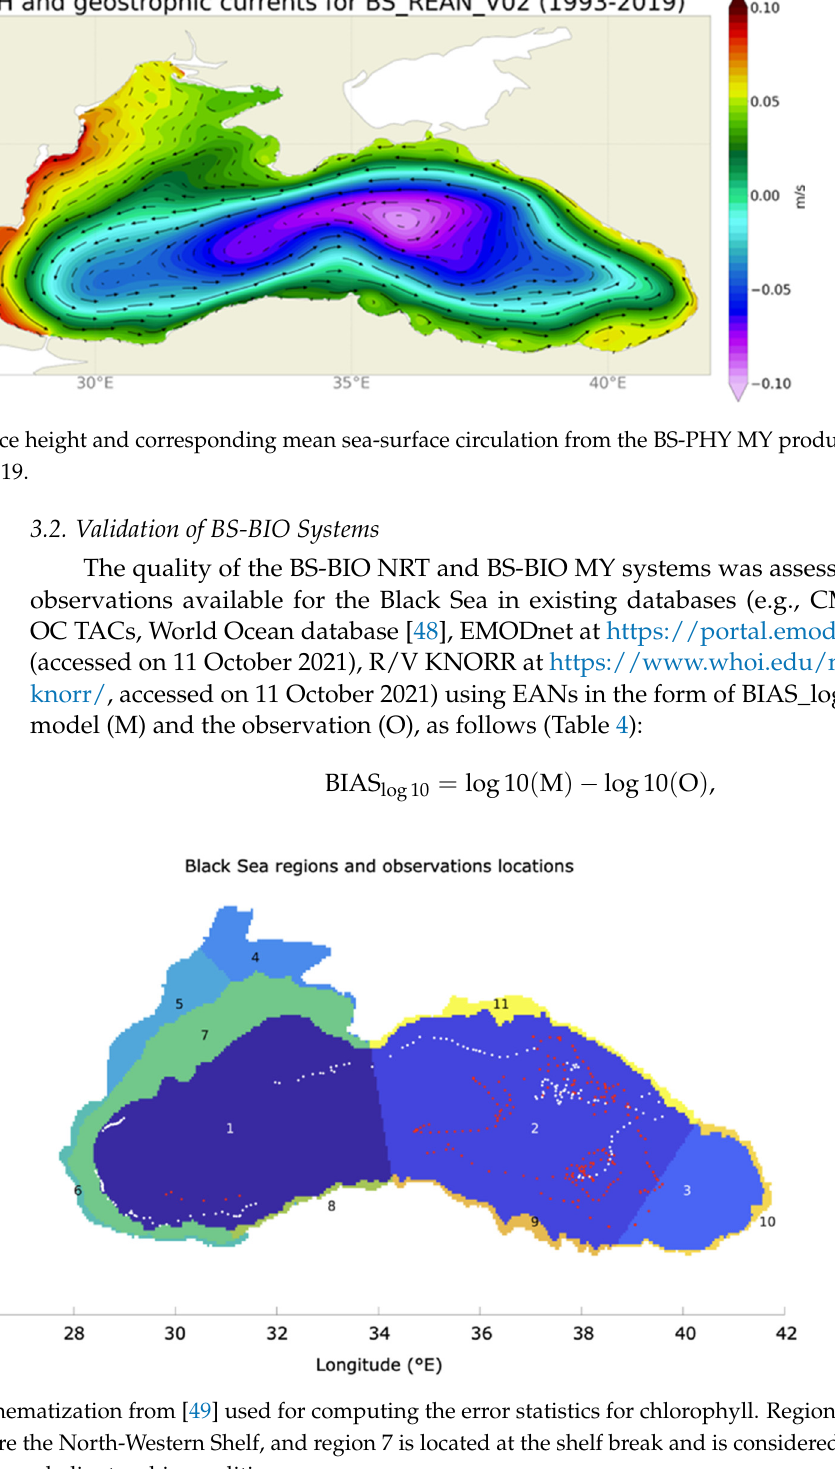
Figure 8. Sub-regions schematization from [49] used for computing the error statistics for chlorophyll. Regions 1–3 are the “open sea”, regions 4–5 are the North-Western Shelf, and region 7 is located at the shelf break and is considered a transition region between eutrophic and oligotrophic conditions.